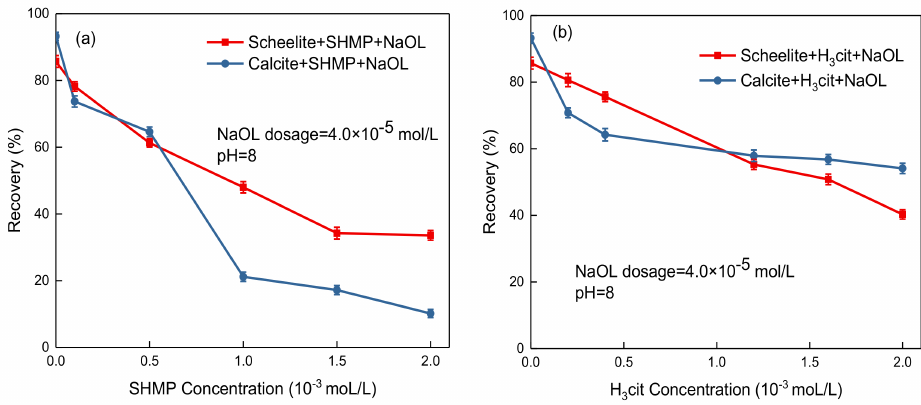
Figure 5. Floatability of minerals as a function of SHMP ( a ) and H 3 Cit ( b ) concentration.